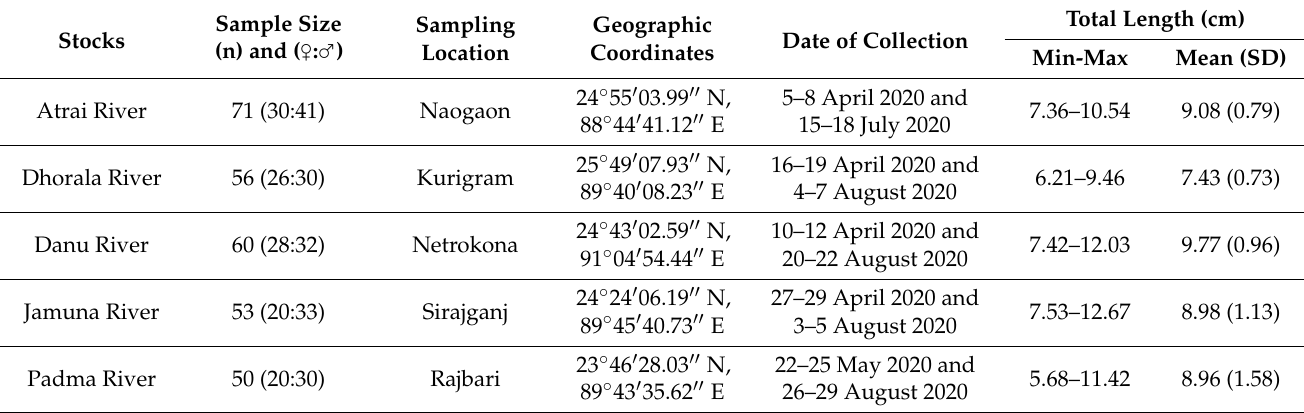
Table 1. Sampling details of Botia dario stock